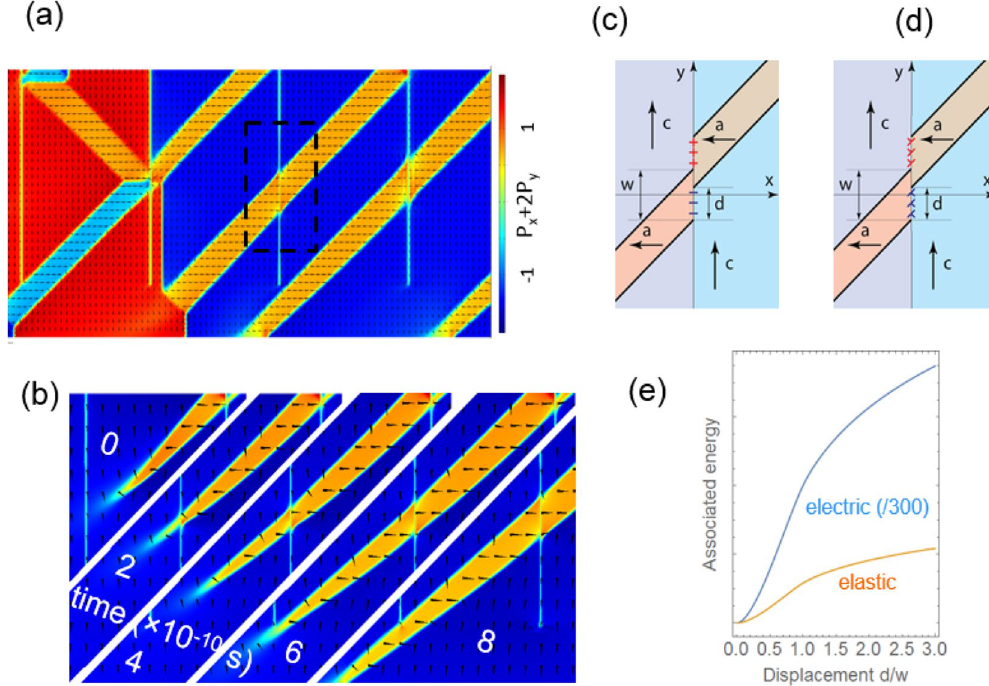
Figure 2. Ferroelastic domains and their interaction with grain boundaries. ( a ) Domain structure calculated using phase field model. ( b ) Five consequent frames (time shown with white font) for the time-dependent simulation showing a-domain growth through a CB, ( c ), ( d ) electrostatic and elastic representation for the domain shift at a CB, showing equivalent charge and fictitious dislocations respectively. ( e ) Electrostatic and elastic energy penalties associated with the a-domain shift d (electric energy reduced by factor 300 to imitate